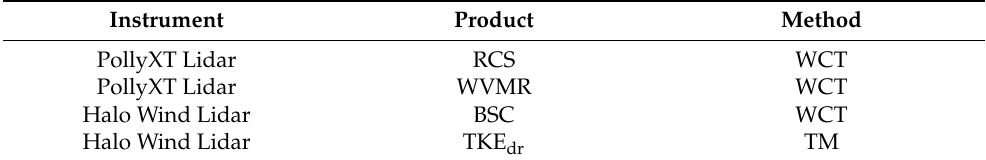
Table 3. Instruments-Products-Methods, abbreviations are presented at the end of the manuscript. Instrument